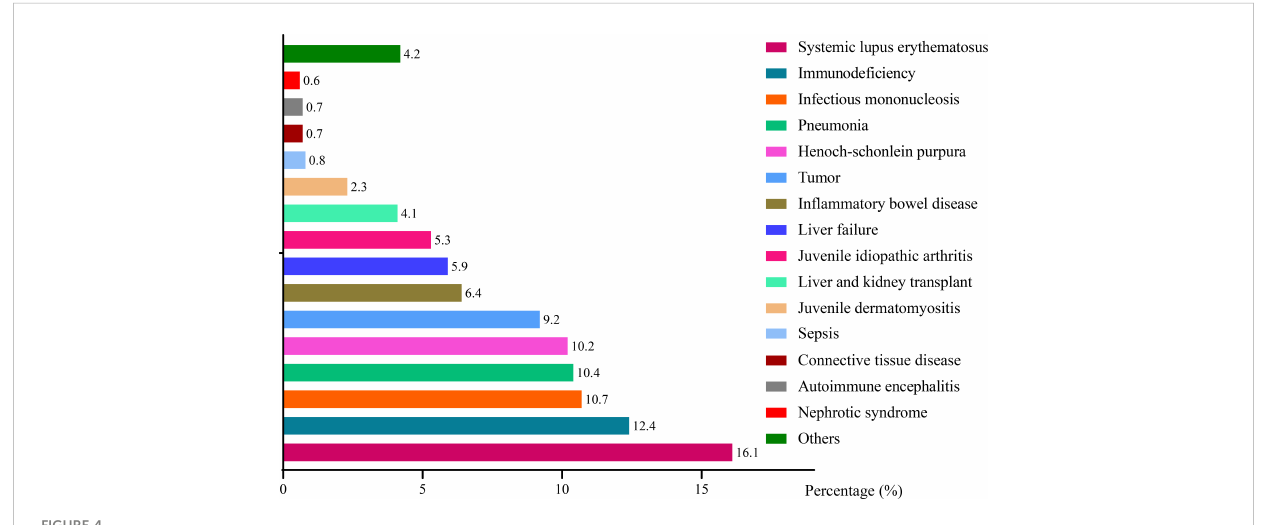
FIGURE 4 Distribution of EBV infection and its related